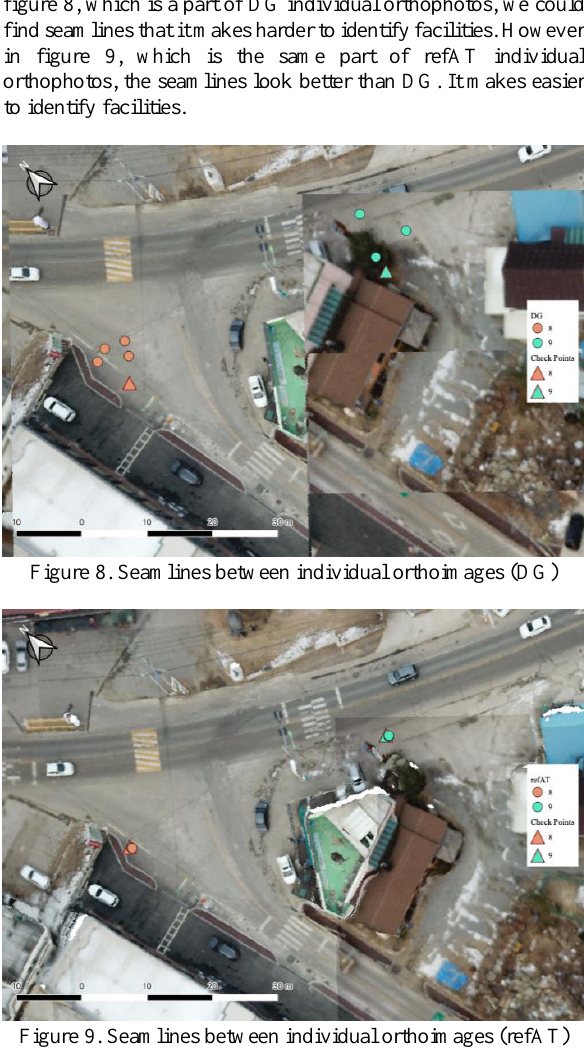
Table 3. Positional accuracy of DG